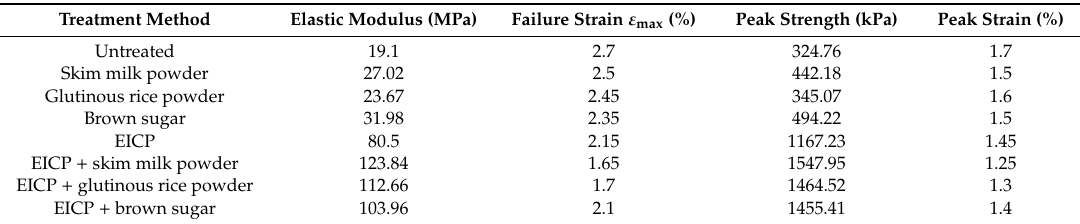
Table 5. Parameters obtained from the UCS tests.